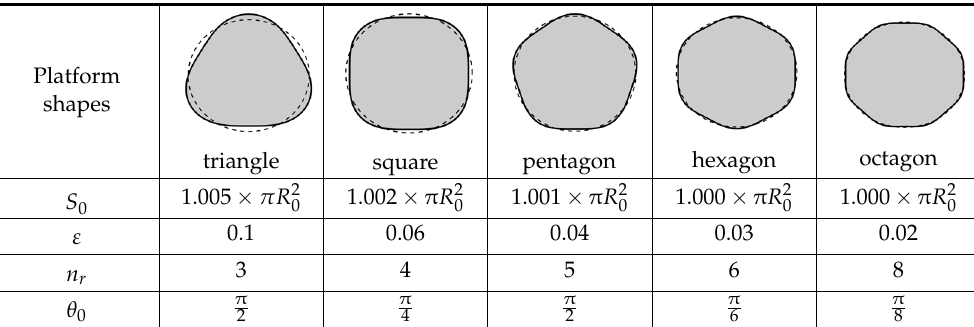
Table 1. Various regular polygonal shapes created by the cosine-type radial perturbation. (Note: S 0 denotes the plan area of platform).